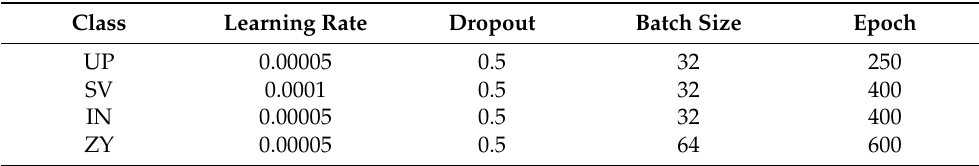
Table 6. Parameter settings on four different datasets inclusive of the learning rate, dropout, batch size, and